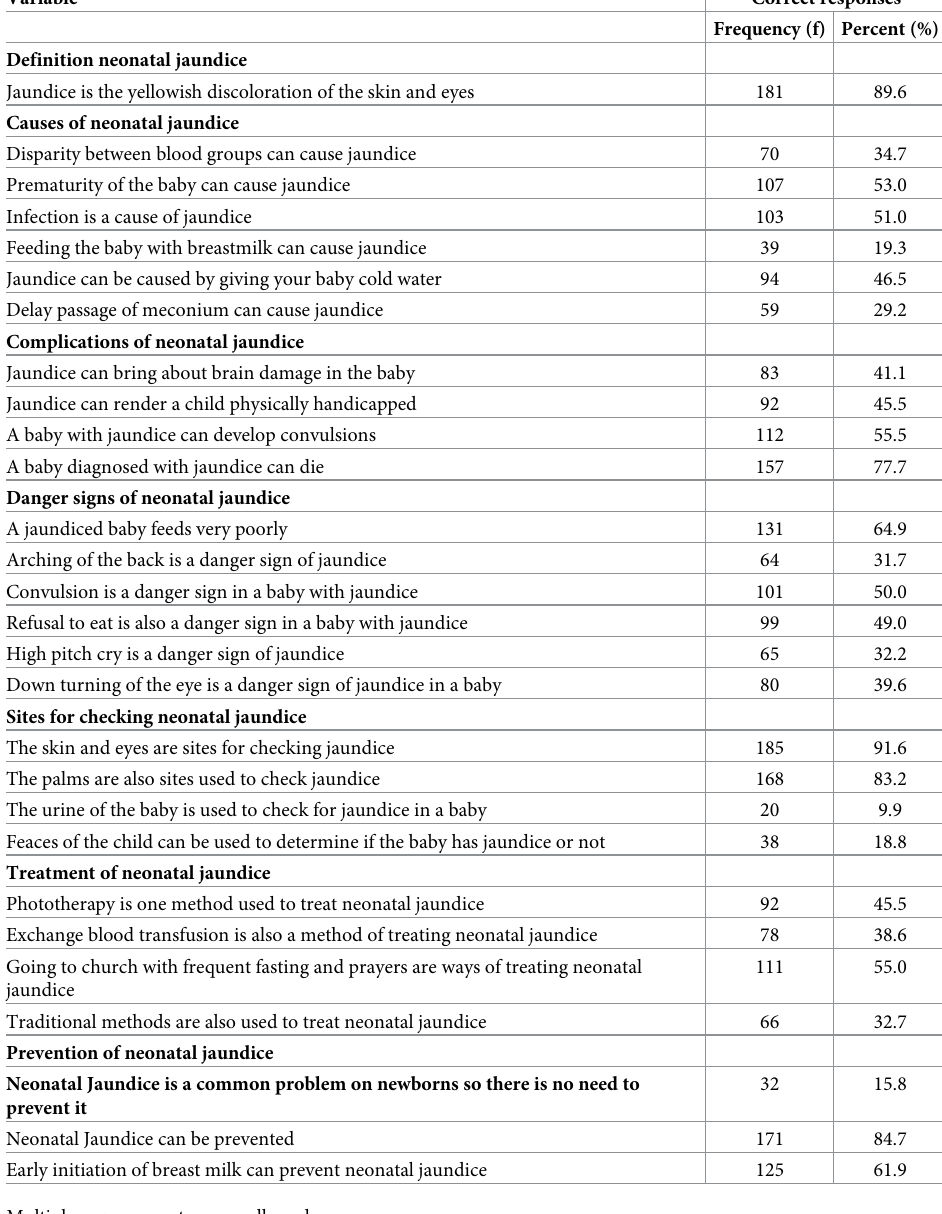
Table 2. Caregivers’ knowledge about neonatal jaundice (n =